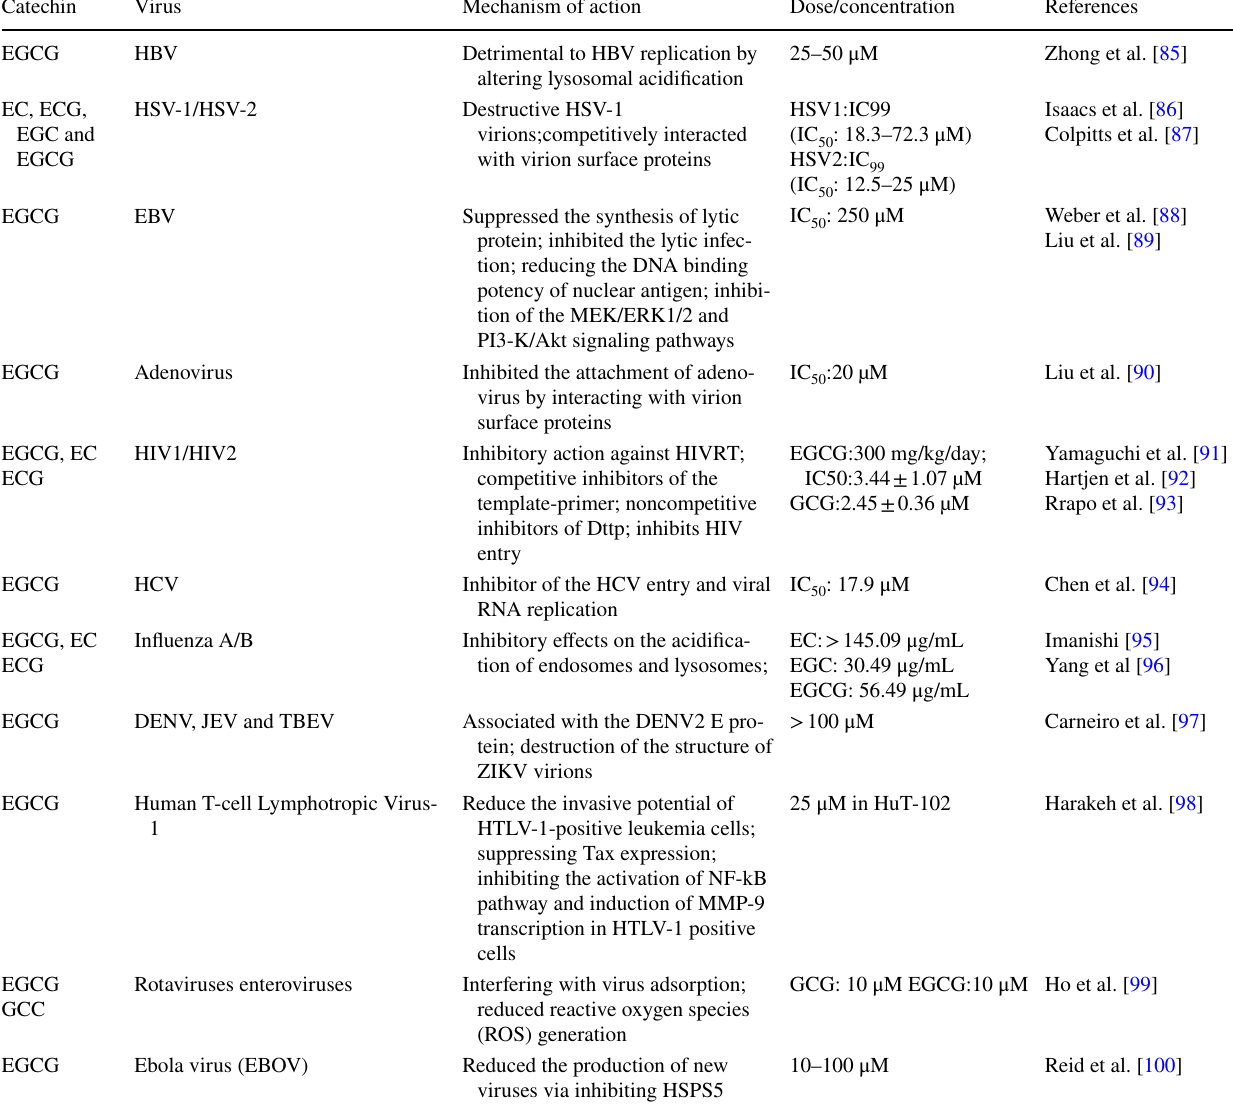
Table 8 Anti-virus activity of catechin/EGCG